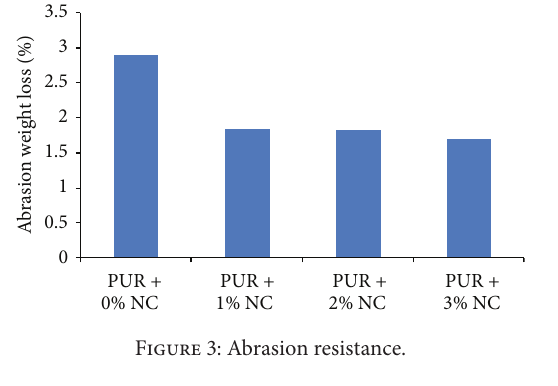
Figure 3: Abrasion resistance.